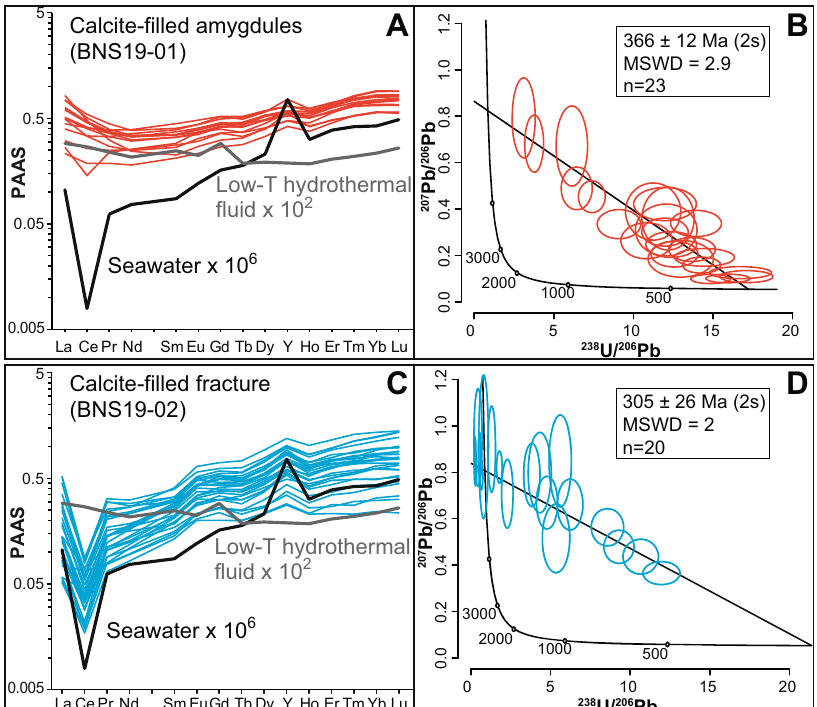
Fig. 4 Age and geochemistry of calcite- fi lled amygdules and fracture. A , C Shale-normalized REY patterns (rare earth elements and yttrium, REE + Y). Post-Archean Australian Shale (PAAS) after ref. 68 , seawater after ref. 39 , and low-temperature (low-T, <12 °C) hydrothermal fl uid after ref. 38 . B , D Tera- Wasserburg concordia plots showing 238 U/ 206 Pb vs. 207 Pb/ 206 Pb. MSWD mean squared weighted